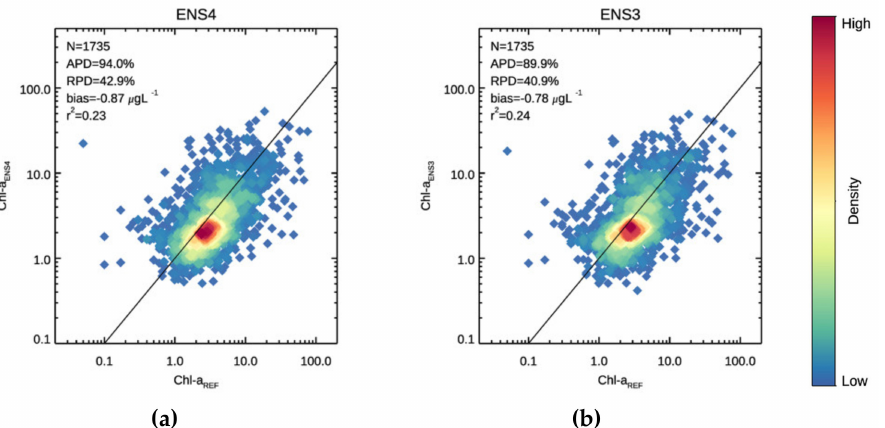
Figure 6. Scatterplots of the satellite-derived and in situ Chl-a co-located observations for the two ensembles. Data points are color-coded by density. The continuous line represents the 1:1 ratio. ( a ) Chl - a ENS 4 : four-element ensemble ( Chl - a MLP _6 b , Chl - a MLP _5 b , Chl - a MLP _4 b , Chl - a MLP _3 b ), and ( b ) Chl - a ENS 3 : three-element ensemble ( Chl - a MLP _5 b , Chl - a MLP _4 b , Chl - a MLP _3 b